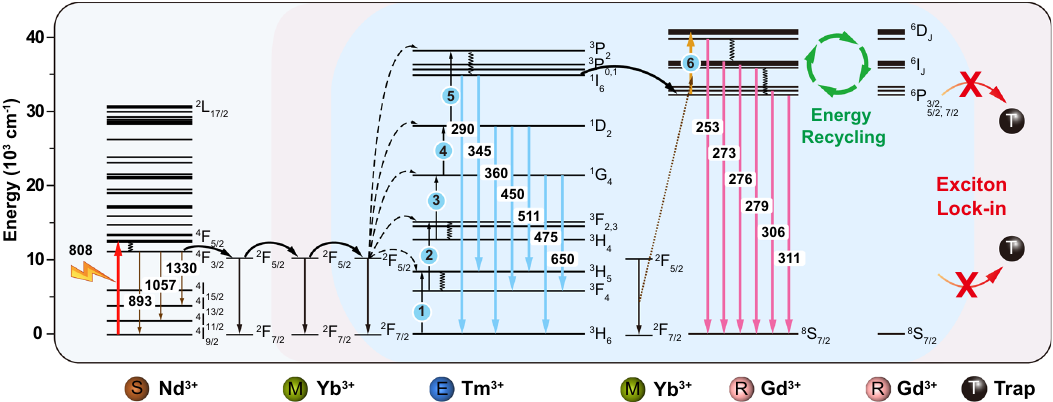
Fig. 2 Schematic energy diagram of heterogeneously doped lanthanide ions and their cascade energy transfer within a core-multishell nanoparticle. When the nanoparticles are excited under 808 nm, Nd 3 + sensitizers fi rst absorb the excitation energy and pass it onto Yb 3 + . Subsequently, the 3 P 2 state of Tm 3 + is populated by a sequential fi ve-photon energy transfer from the network of excited Yb 3 + ions and relaxes to 1 I 6 . The 6 D J state of Gd 3 + is populated via a stepwise process of a fi ve-photon energy transfer process from Tm 3 + and a further energy transfer from Yb 3 + , giving rise to the sixth-photon upconversion luminescence. The inert NaYF 4 host lattice layer can lock-in the Gd 3 + excitation energy and reuse the energy that would otherwise be depopulated by deleterious energy traps within the nanoparticles, resulting in upconversion emissions in the UVB and UVC ( ∼ 8750 cm − 1 , Gd 3 + ) 41 – 43 . Thus, UVC and UVB upconversion